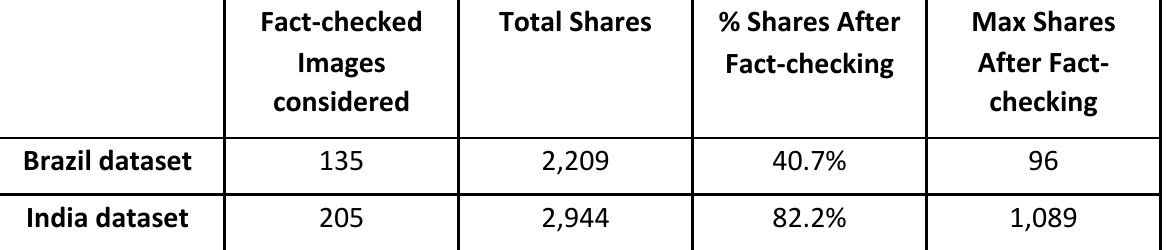
Table 1 . Number of images containing misinformation shared in our WhatsApp dataset from Brazil and India and comparison of shares before and after the checking date of fact-checking